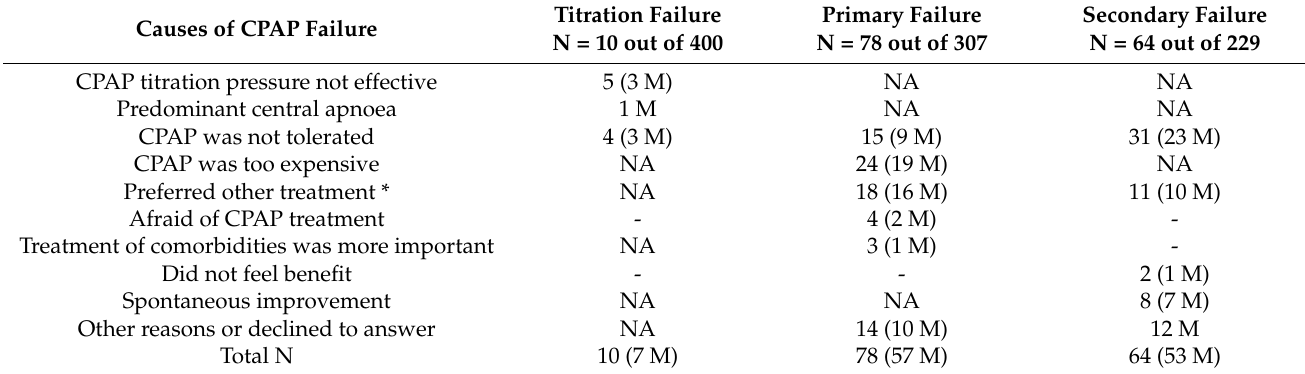
Table 2. Causes of CPAP titration, primary and secondary